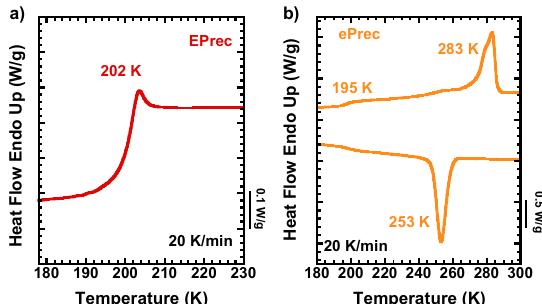
Fig. 1. DSC (a) heating scan for EPrec sample after the previous cooling process and (b) cooling and heating scans for ePrec sample at 20 K/min.